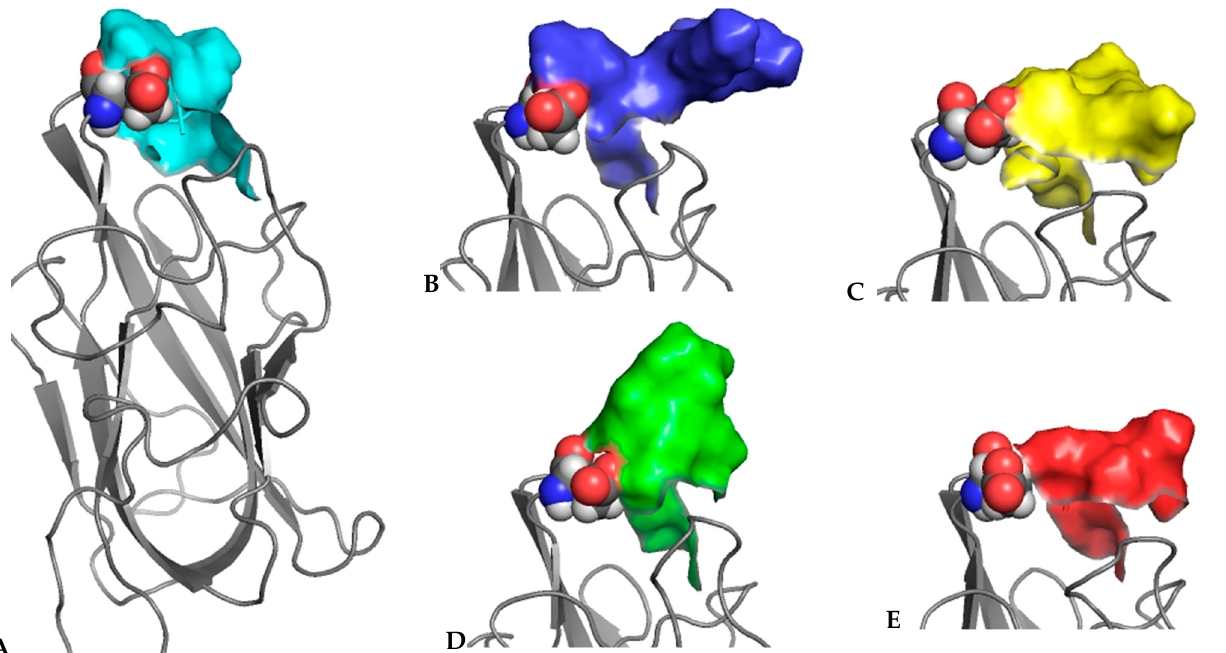
Figure 5. Representative structures of NRP2 in complex with peptides ( A ) C (cyan), ( B ) B167 (blue), ( C ) B186 (yellow), ( D ) A165 (green) and ( E ) control (red). Centroid of the most populated clusters were extracted from trajectories of 30 ns molecular dynamics simulations, with NRP2 shown as a grey ribbon and Glu351 in CPK representation, while the peptides were shown as solvent-accessible surfaces.